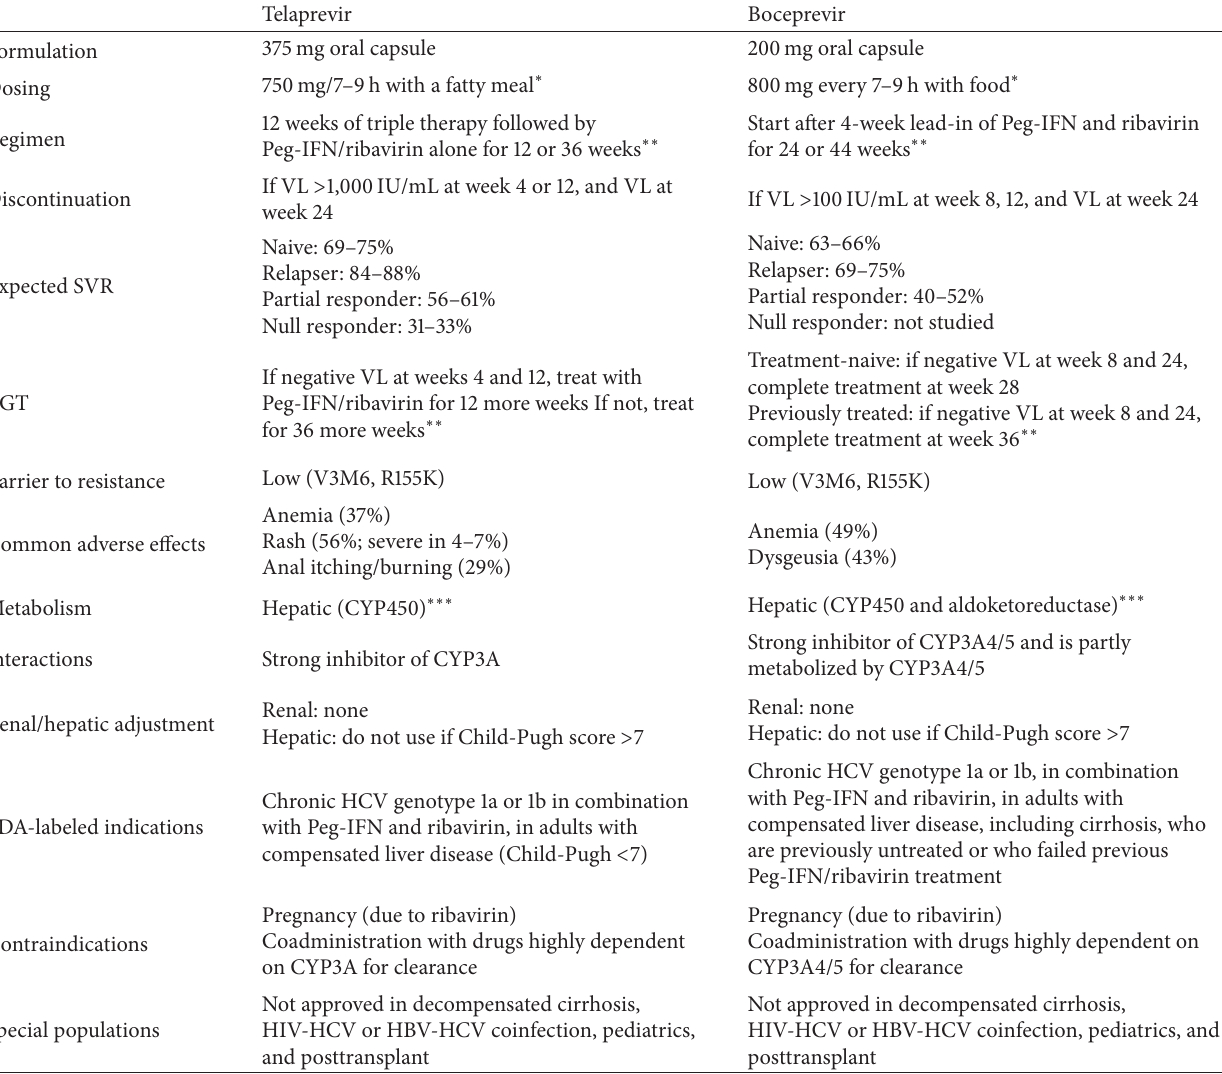
Table 2: FDA approved directly acting antiviral drugs—telaprevir (Incivek) and boceprevir (Victrelis). Modified from Assis and Lin [9]. Telaprevir